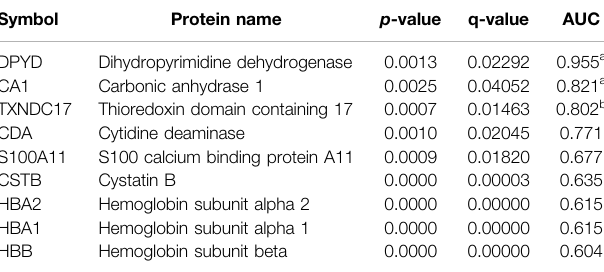
TABLE 2 | Differentially up-regulated proteins in